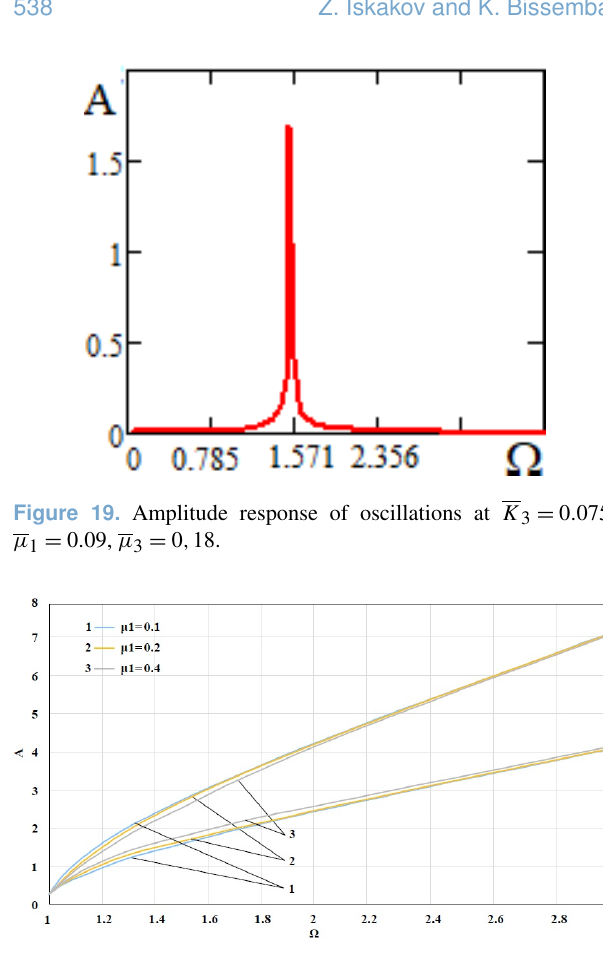
Figure 20. The boundaries of the instability region for a system with a coefficient of non-linear stiffness of the support K 3 = 0 . 2 and different values of linear viscous damping coefficient µ 1 .